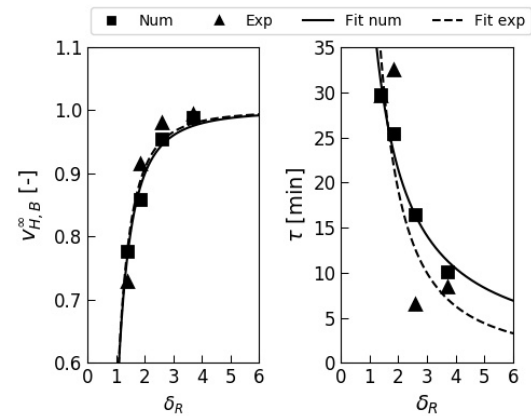
Fig. 3. On the left: the final volume fraction of the heavy component, 𝑣 0,12 , evaluated at the bottom layer of the cell. On the right: the time required to reach the 88% of 𝑣 0,12 . Square and triangular markers indicate numerical and experimental results, respectively. Furthermore, they are fitted with power functions and represented as solid lines and dashed lines respectively. In the case of 𝑣 0,12 , numerical and experimental fittings coincide